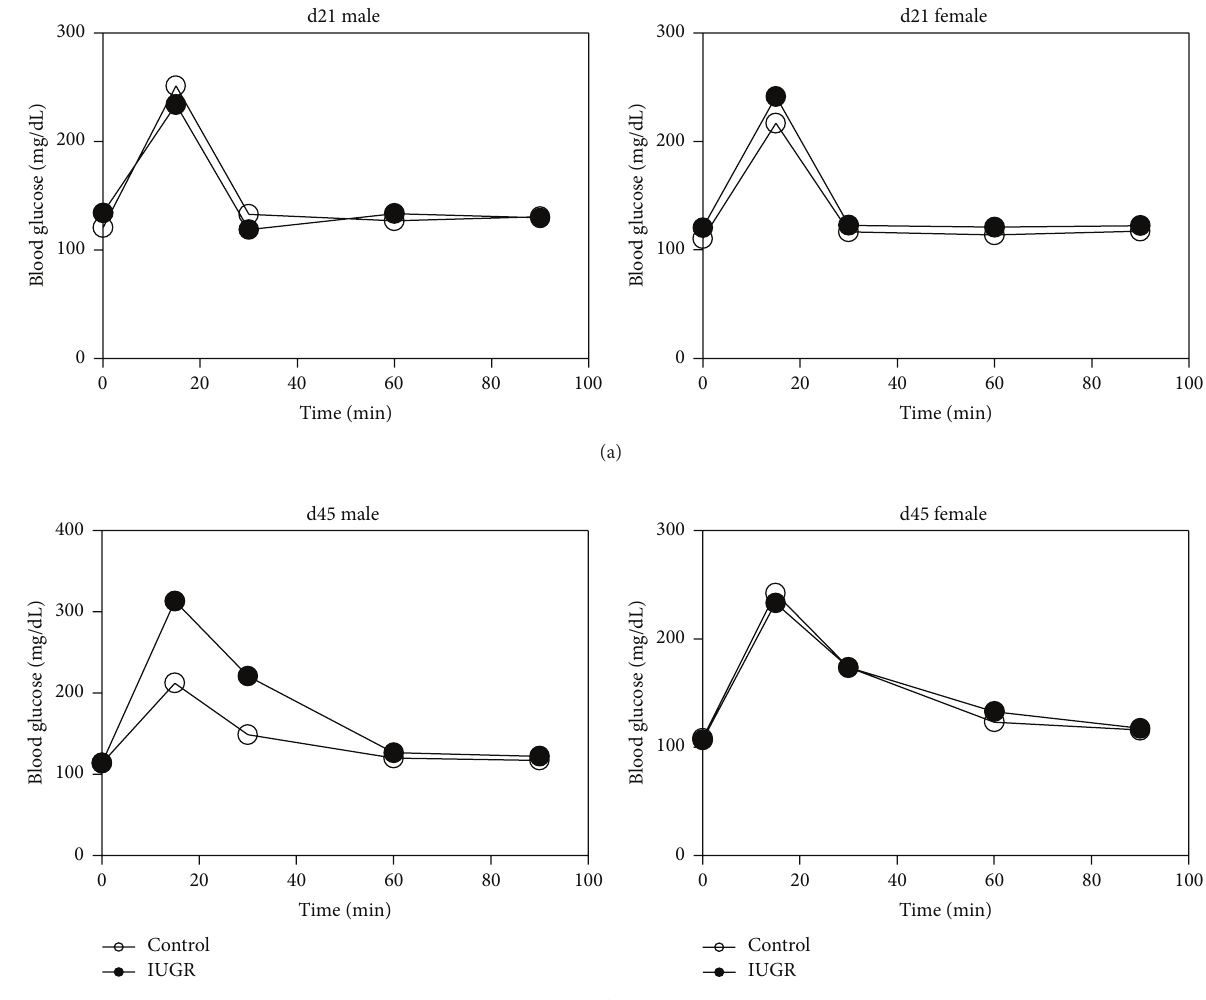
Figure 6: Glucose tolerance tests. IUGR impairs glucose tolerance in d45 in male rats. Results are control (white circles) and IUGR (black circles) Errors are SD. 𝑛 = 4 , ∗ 𝑃 ≤ 0.05